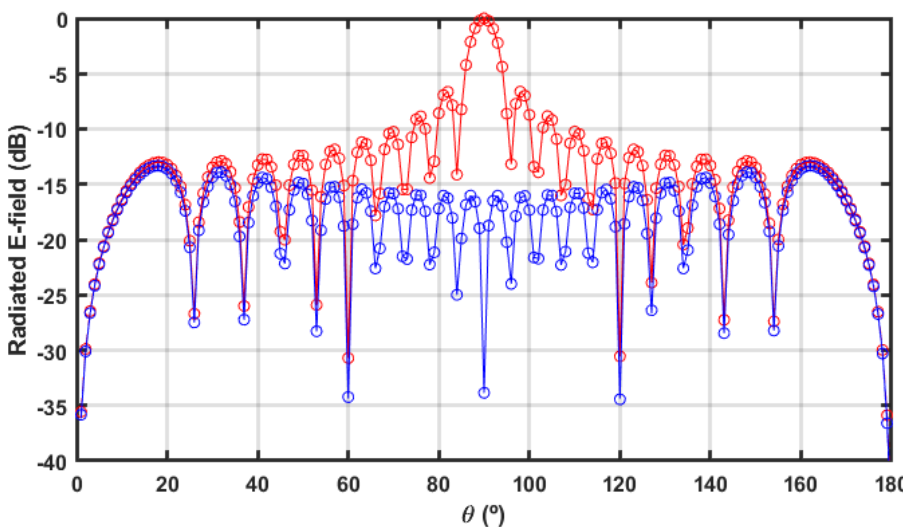
Figure 18. Radiated E-fields. Case Table 2-(1) with 20 antennas step = 0.12 m: (---) Horizontal polarization (E φ ). (-o-) Horizontal polarization (E φ ) with helix. (---) E θ without helix. (-o-) E θ with helix.